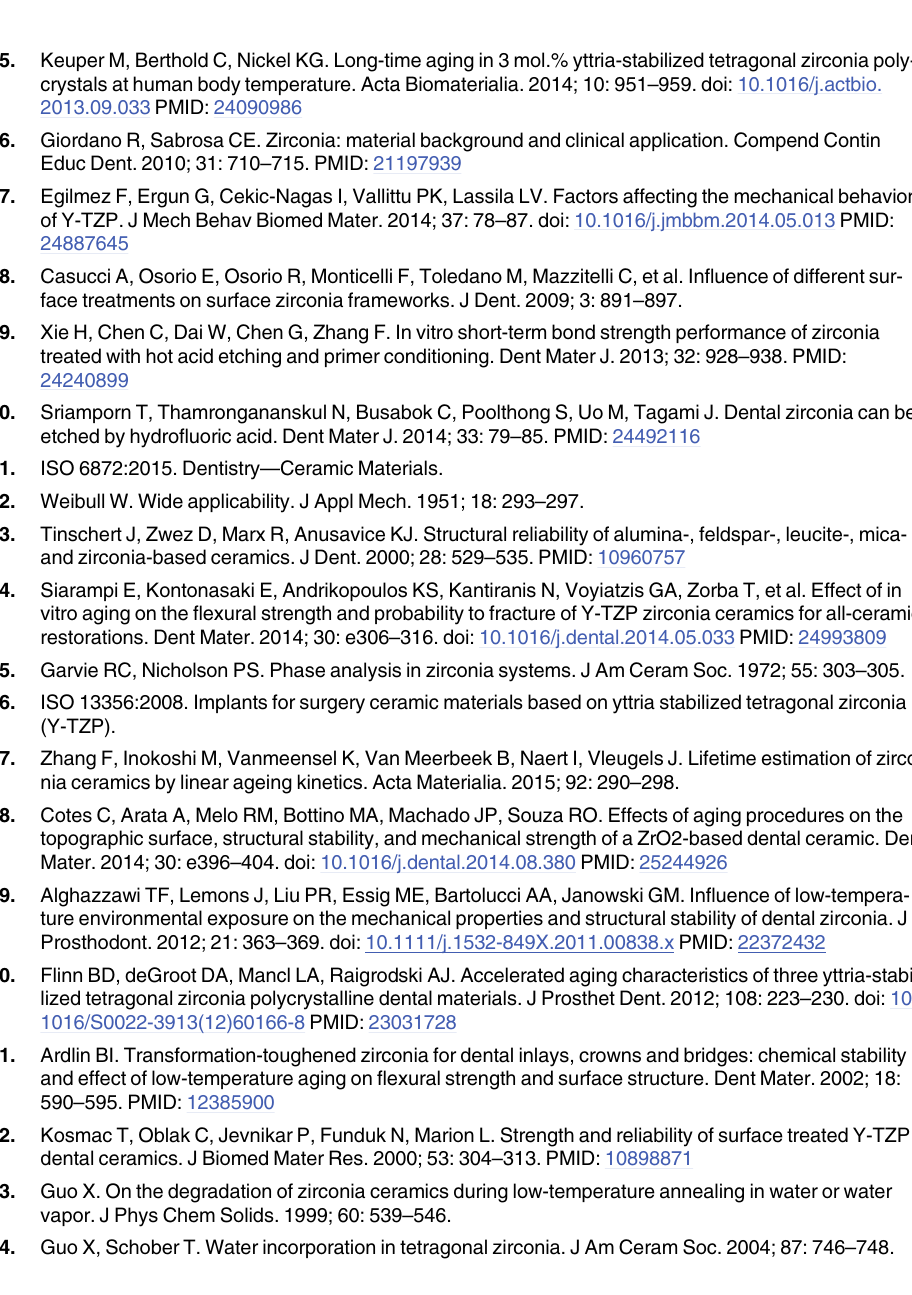
PLOS ONE | DOI:10.1371/journal.pone.0136263 August 24,